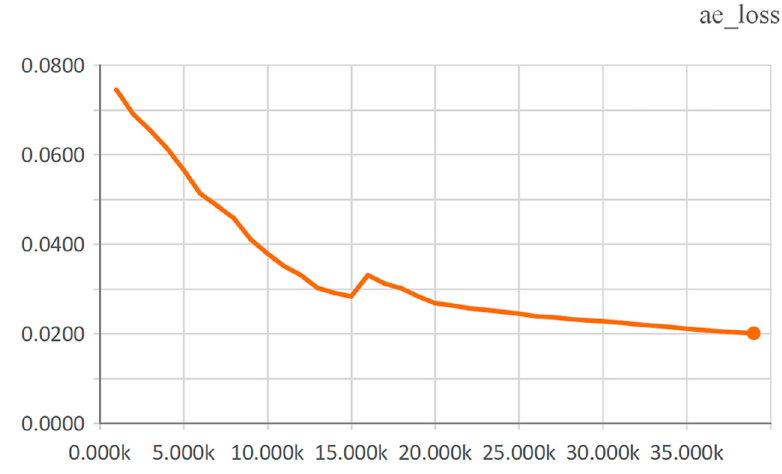
Figure 3. DEM data. ( a ) Data of Norway; ( b ) data of a place in Jiangsu province; and ( c ) data of a place in Sichuan province.